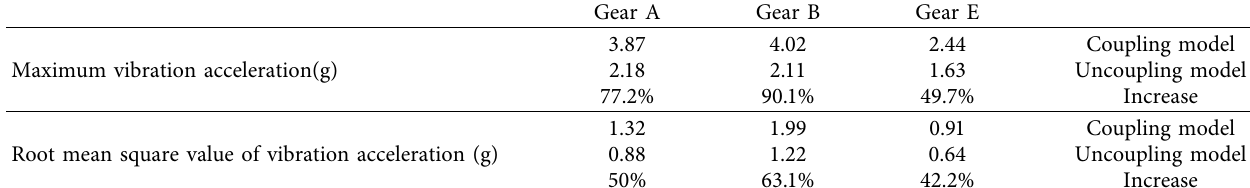
Table 5: Comparison of mass point bending vibration acceleration